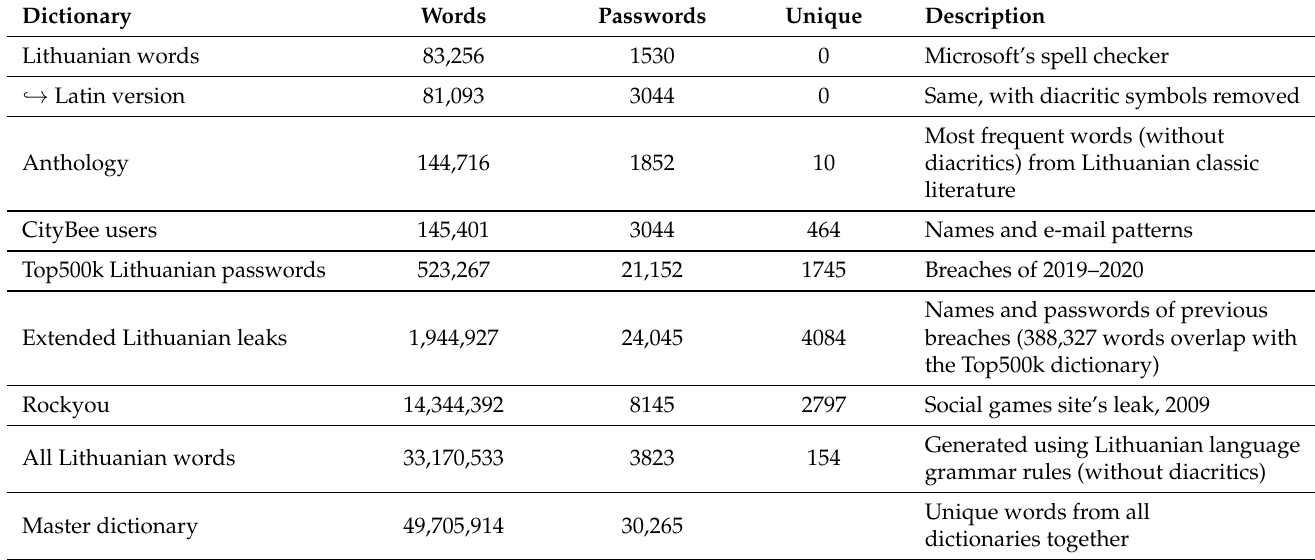
Table 1. Dictionaries used and the corresponding number of matching